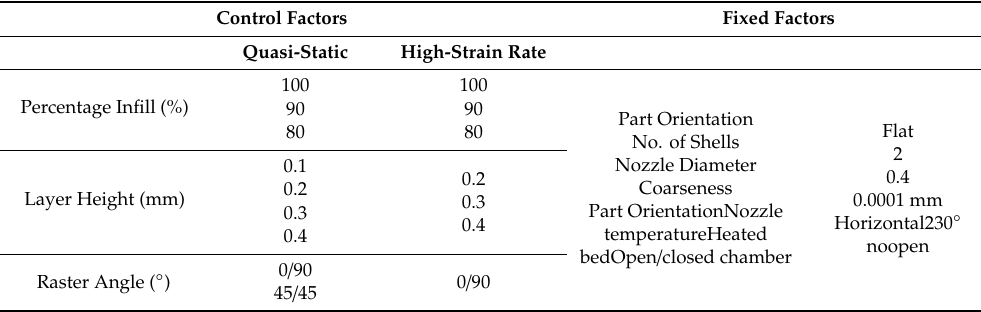
Table 2. The 3D printing process parameters of thermoplastic urethane samples.